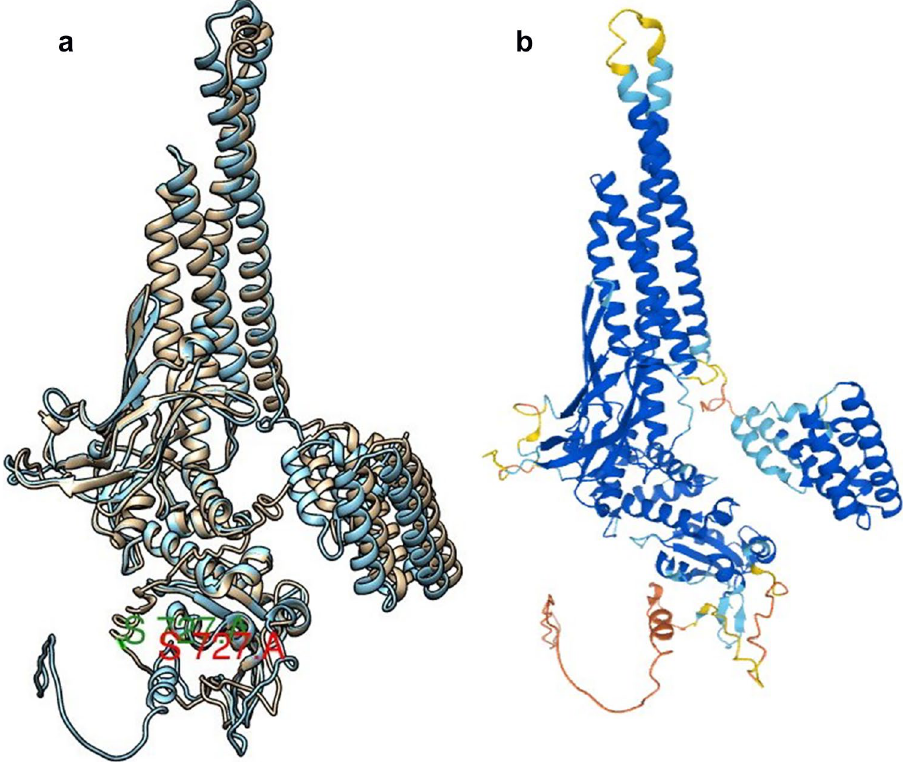
Figure 2. ( a ) Superimposed structures of STAT3, I-TASSER-generated structure is in gold color while AlphaFold2-generated one is in blue color. Ser727 residue is labelled in each structure. The NTD region, a part of CC region and TAD region is seen displaced with respect to each other. ( b ) AlphaFold2-derived structure: model confidence as per pLDDT values, colored in blue: very high confidence regions, pLDDT > 50, colored in orange and yellow: very low confidence regions, pLDDT <